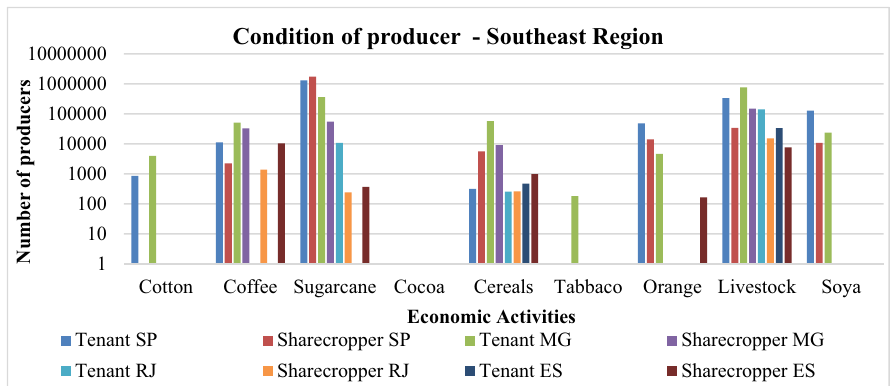
Figure 3: Main economic activities in the rural sector according to the condition of the producers in relation to land ( in hectares ) – Southeast region ( 2017 ) Source: Own elaboration from ref. [ 47 ] .